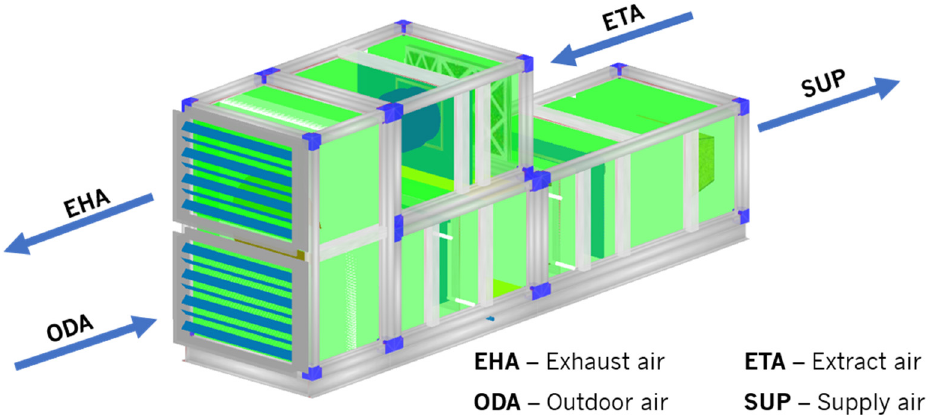
Figure 1. AHU under analysis and their respective components.